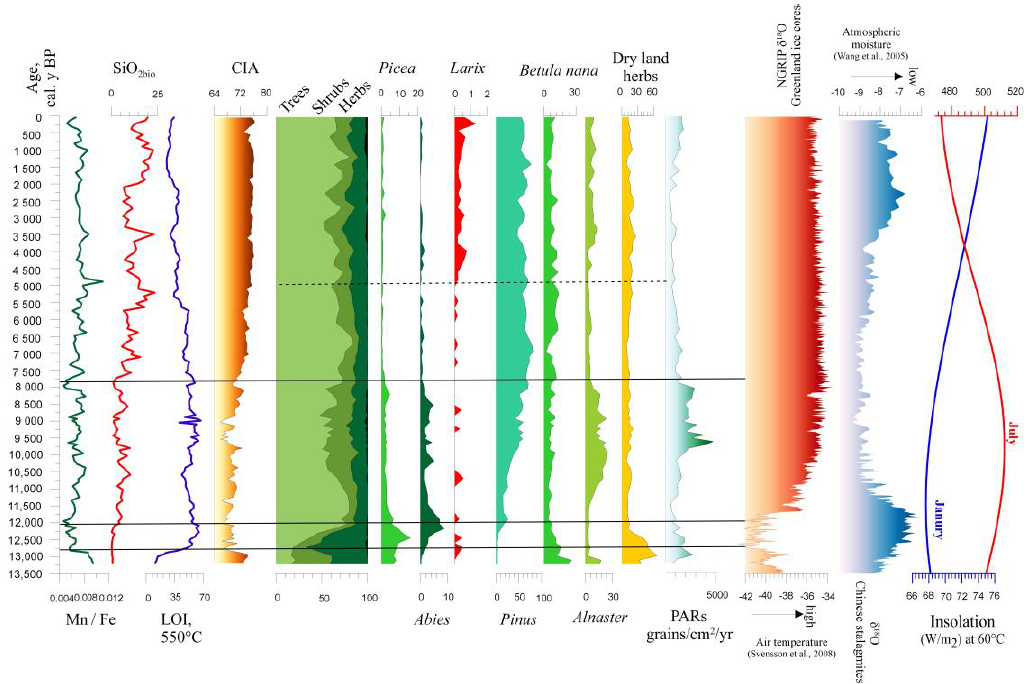
Figure 6. Comparison of palaeoenvironmental indicators from Lake Kaskadnoe-1 and the δ 18 O records from Greenland, as an indicator of the northern hemisphere (NH) air temperature [53], and from Chinese stalagmites [54], as an indicator of the Pacific moisture-bearing monsoon intensity, and the NH June insolation at 55°N [55], plotted on their respective time scales. The black horizontal lines delineate the identified local geochemical zones (LGZ 1 – 3) shown in Figures 3 and 4. The uppermost dotted horizontal line highlights the appearance of larch trees near the Lake Kaskadnoe basin due to changes in the Late Holocene environment. (For interpretation of the references to color in this figure legend, the reader is referred to the web version of this article.)